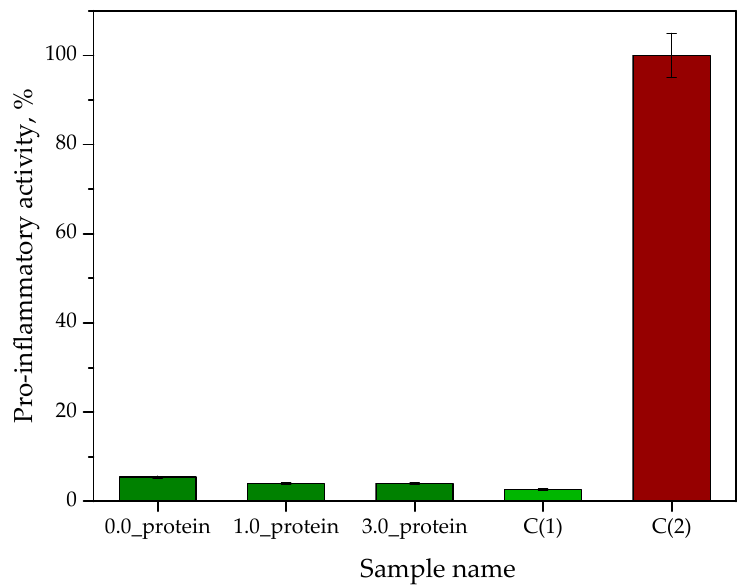
Figure 13. Results of analysis of hydrogels’ pro-inflammatory activity ( n —number of repetitions Figure 13 . Results of analysis of hydrogels ’ pro-inflammatory activity (number of repetitions n = 3). n = 3). NF- κ B (nuclear factor kappa-light-chain-enhancer of activated B cells) is one of the